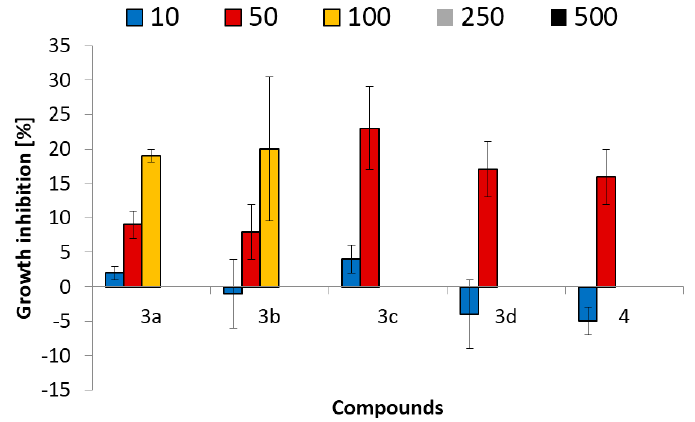
Figure 3. Growth inhibition (%) of Heterocypris incongruens living in soil contaminated with pyrene- derived aminophosphonates 3a – d and 4 at concentrations of 10, 50, 100 and 500 mg/kg of soil dry weight. Error bars represent standard deviation error (SD, n = 6 determinations).